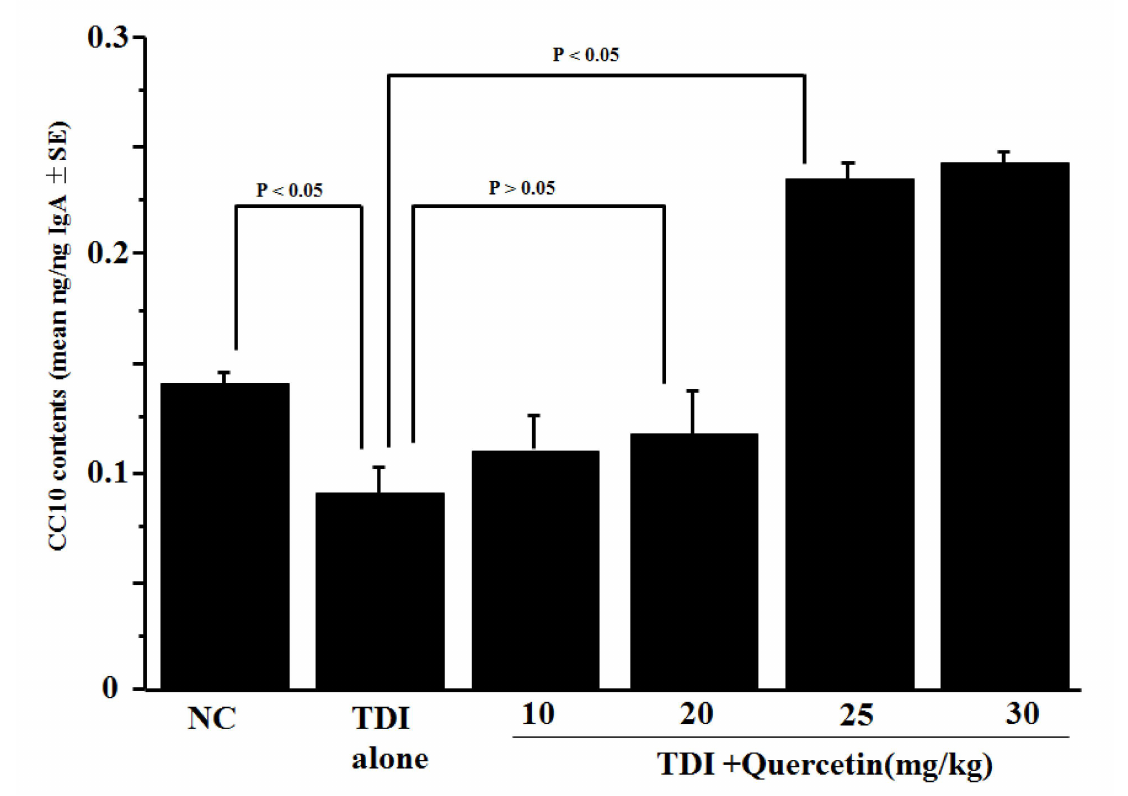
Figure 2. Influence of quercetin on the appearance of CC10 in nasal lavage fluid obtained from toluene 2.4-diisocyanate (TDI)-sensitised rats after the TDI nasal challenge. TDI-sensitised rats were treated orally with quercetin once a day for five days. Nasal lavage fluid was obtained from rats 6 h after the nasal TDI challenge. CC10 levels were examined using ELISA. The data are expressed as the mean ng/ng IgA ± SE of five